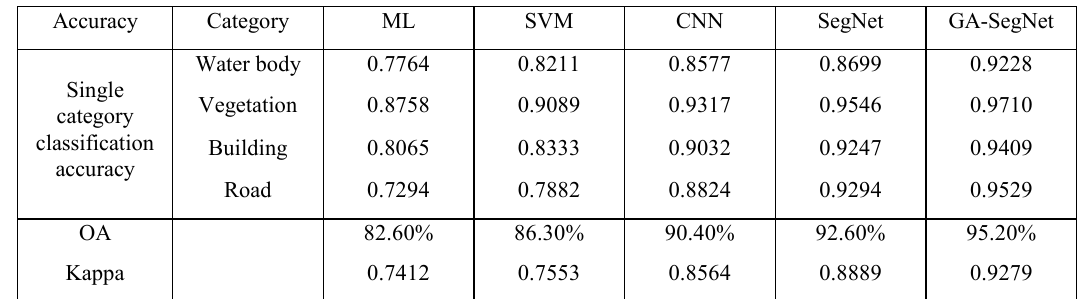
Table 6. Accuracy comparison of classification results of different classification methods